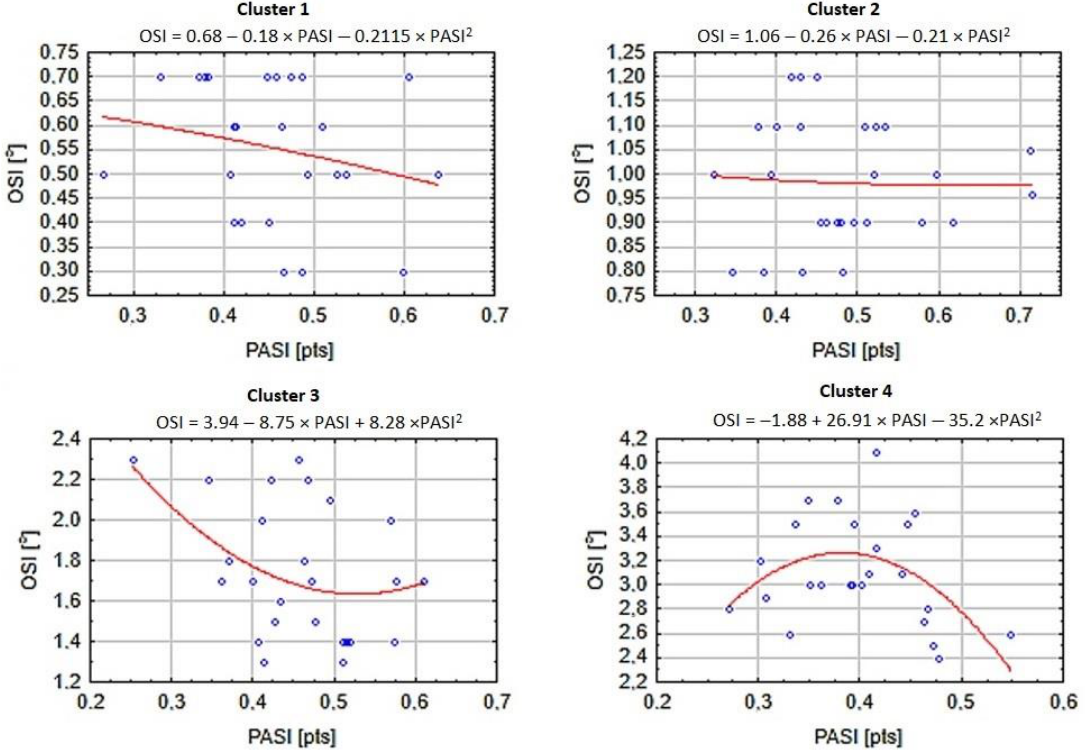
Figure 3. The functional form between PA and OSI by cluster.